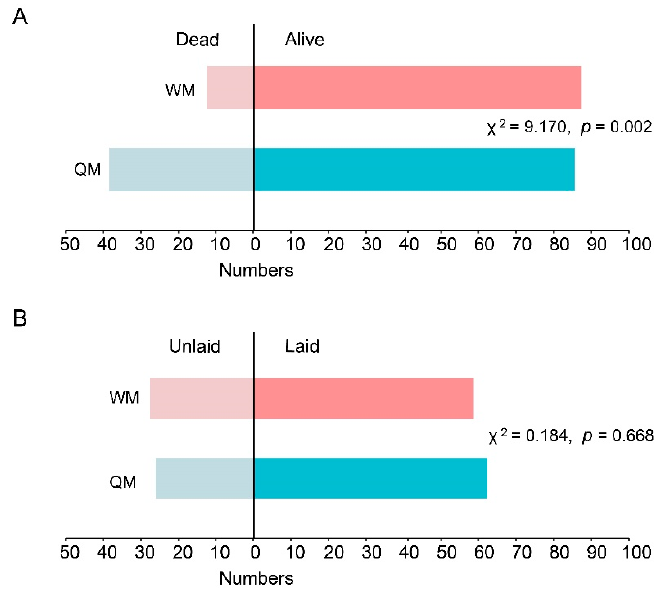
Figure 4. The survival rates and egg-laying rates of the QM- and the WM-mated queens. ( A ) The number of dead and alive QM- and WM-mated queens after diapause; ( B ) the number of laid and unlaid QM- and WM-mated queens after 20 days’ rearing. The Pearson chi-square test was used to analyze the differences in survival results of QM- and WM-mated queens after diapause and egg-laying results after 20 days’ rearing.